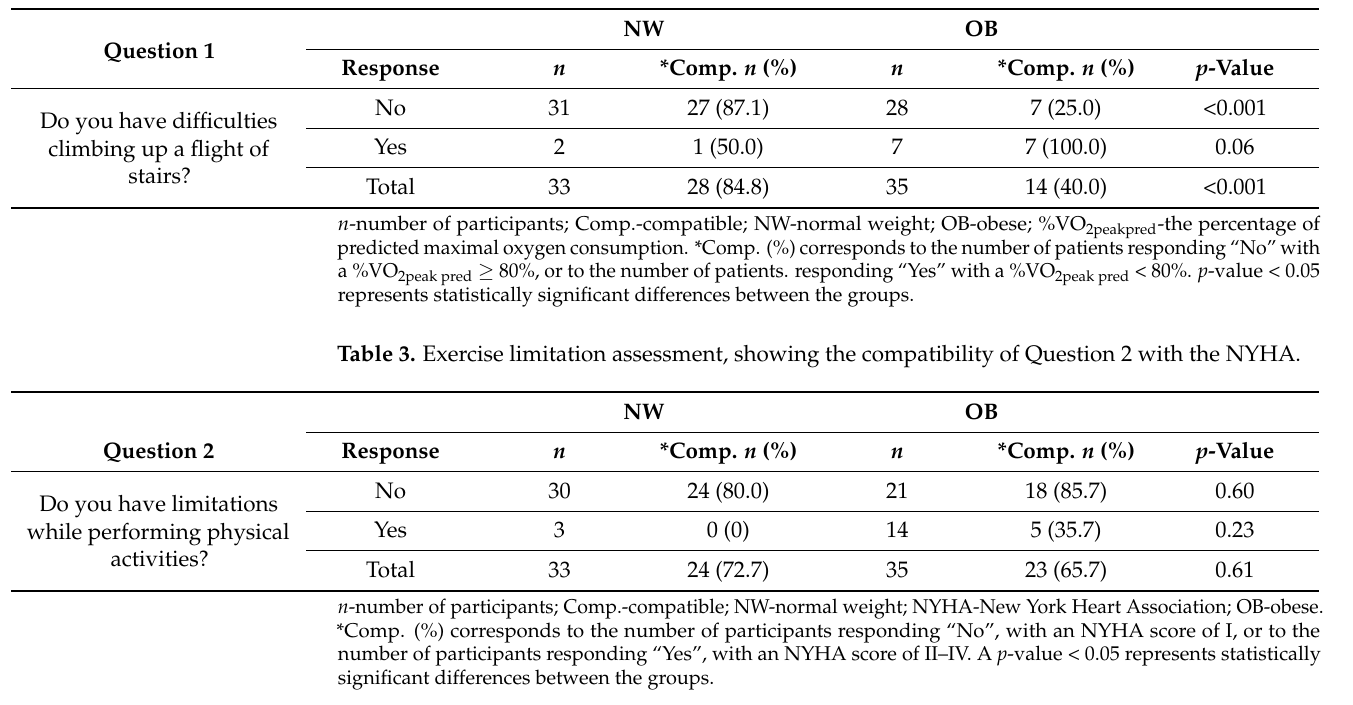
Table 2. Exercise capacity assessment, showing the compatibility of Question 1 to %VO 2peak pred .